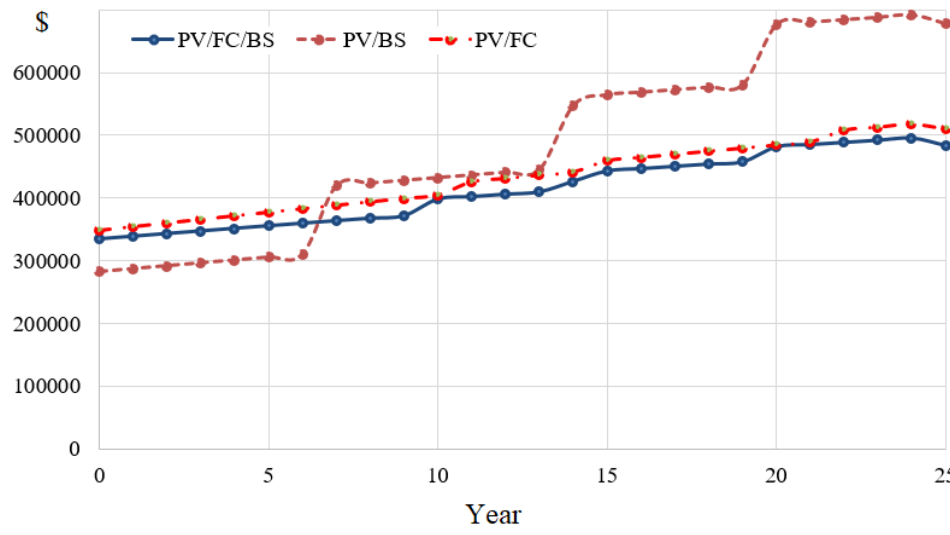
Figure 11. The discounted cash flows related to every considered system.